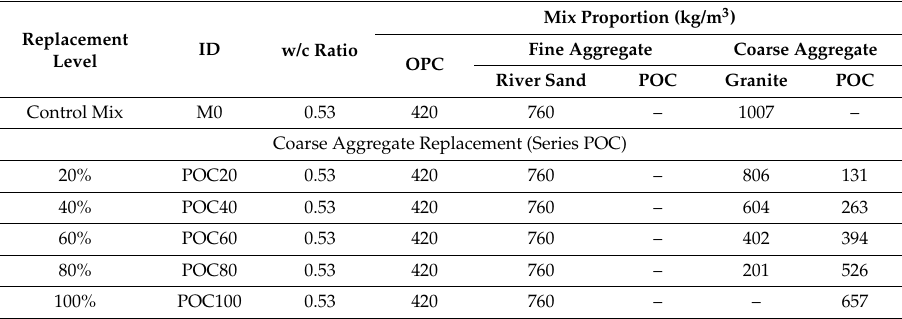
Table 3. Mixture proportion for different replacement level of coarse aggregate.